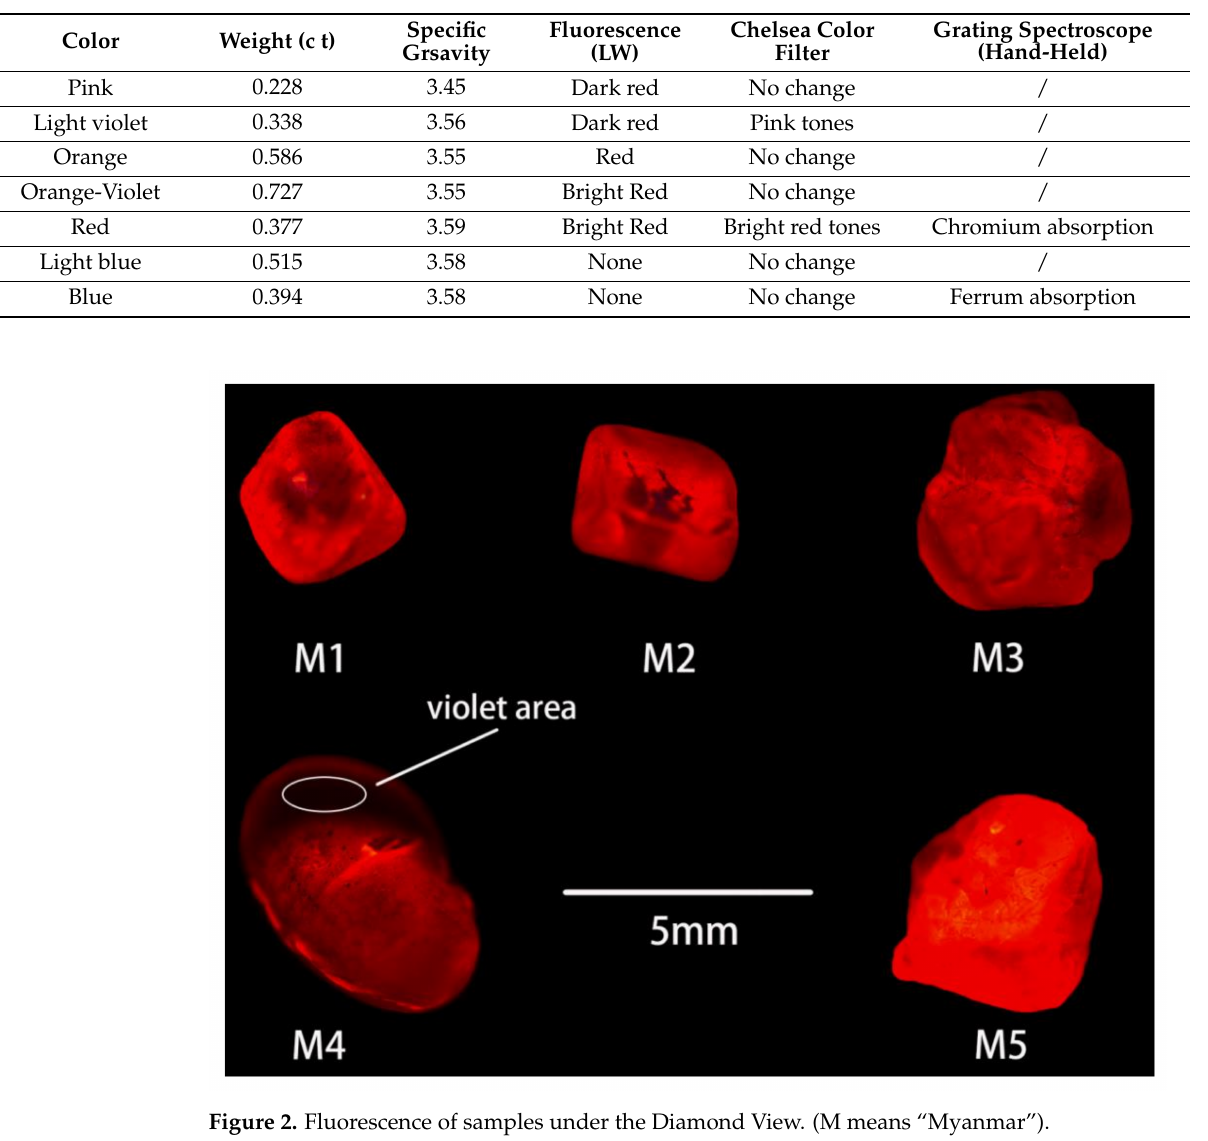
Table 1. Gemological characteristics of the samples.